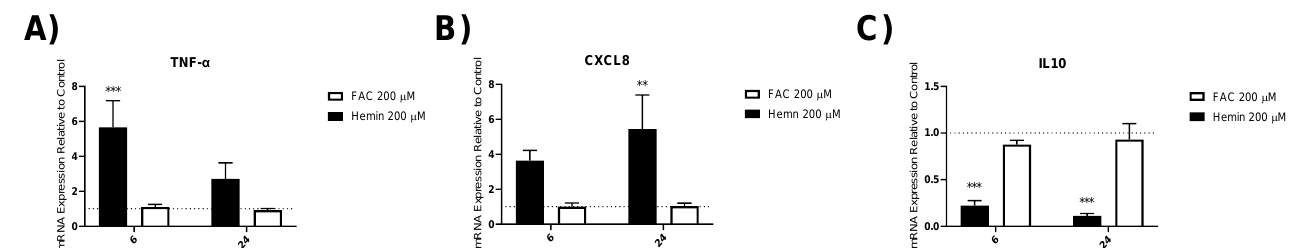
Figure 3. Inflammatory marker gene expression in iron-treated lung macrophages. TNF-α, CXCL8 and IL10 expression in lung macrophages treated with 200 μM of hemin or ferric ammonium citrate (FAC) ( A – C ). Real-time qPCR was used to assess levels of gene expression after 6 and 24 h. Gene expression is plotted as means relative to GAPDH and untreated control for each patient (2 −ΔΔCt ) ±SEM in smokers and COPD patients ( n = 6). Dotted line at 1 indicates untreated control. One-way ANOVAs were carried out with a post hoc Dunnett’s multiple comparisons test against time-matched untreated controls. ** = p < 0.01, *** = p < 0.001.